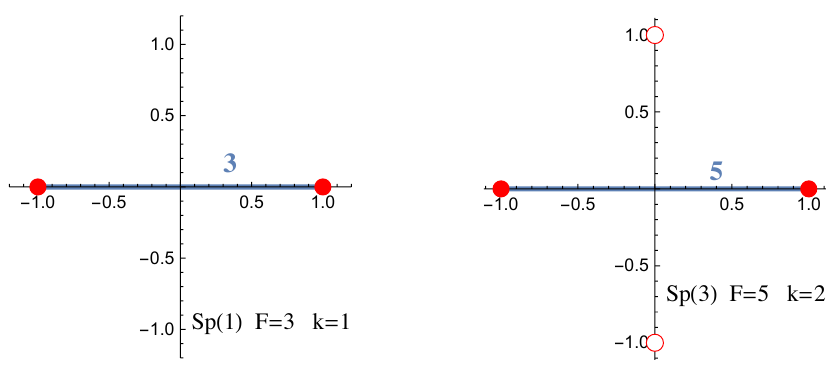
domain walls: on the left a 1-wall solution of Sp(1) with F = 3 Figure 6 . Examples of k = N +1 2 flavors, on the right a 2-wall solution of Sp(3) with F = 5